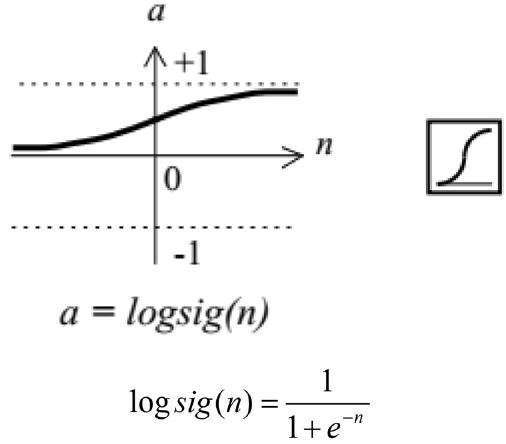
Fig. 1 Plot of the log-sigmoid transfer function (Demuth and Beale 2002)